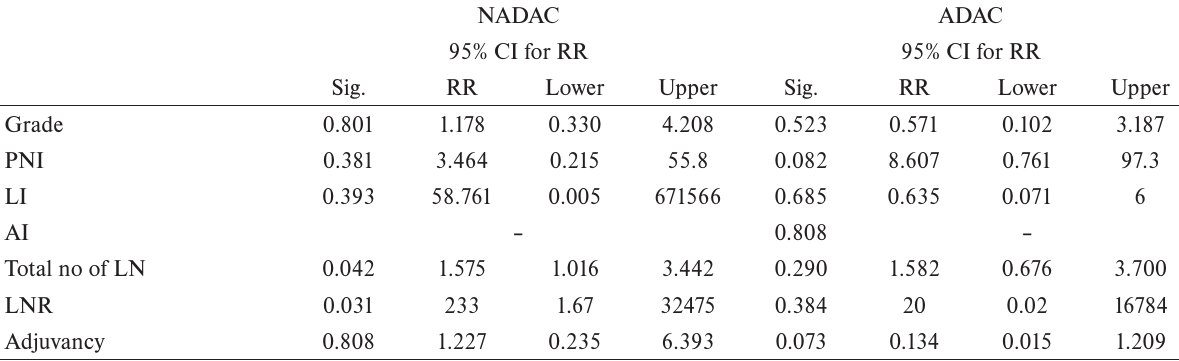
Table 3. Disease-free survival (DFS) and parameters in NADAC and ADAC. NADAC ADAC 95% CI for RR